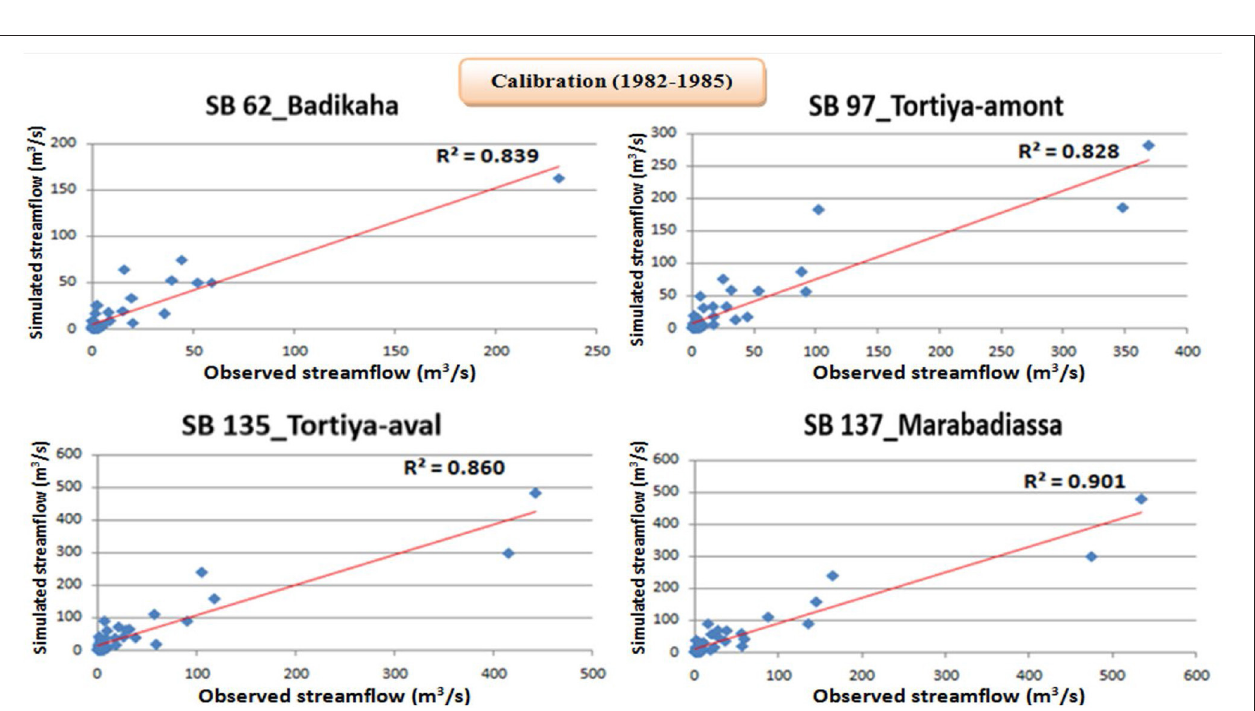
FIGURE 5 | Correlation between the observed and simulated monthly average streamflows in SB 62 (Badikaha station), SB 97 (Tortiya-amont station), SB 135 (Tortiya-aval station), and SB 137 (Marabadiassa station) during the calibration period 1982–1985.